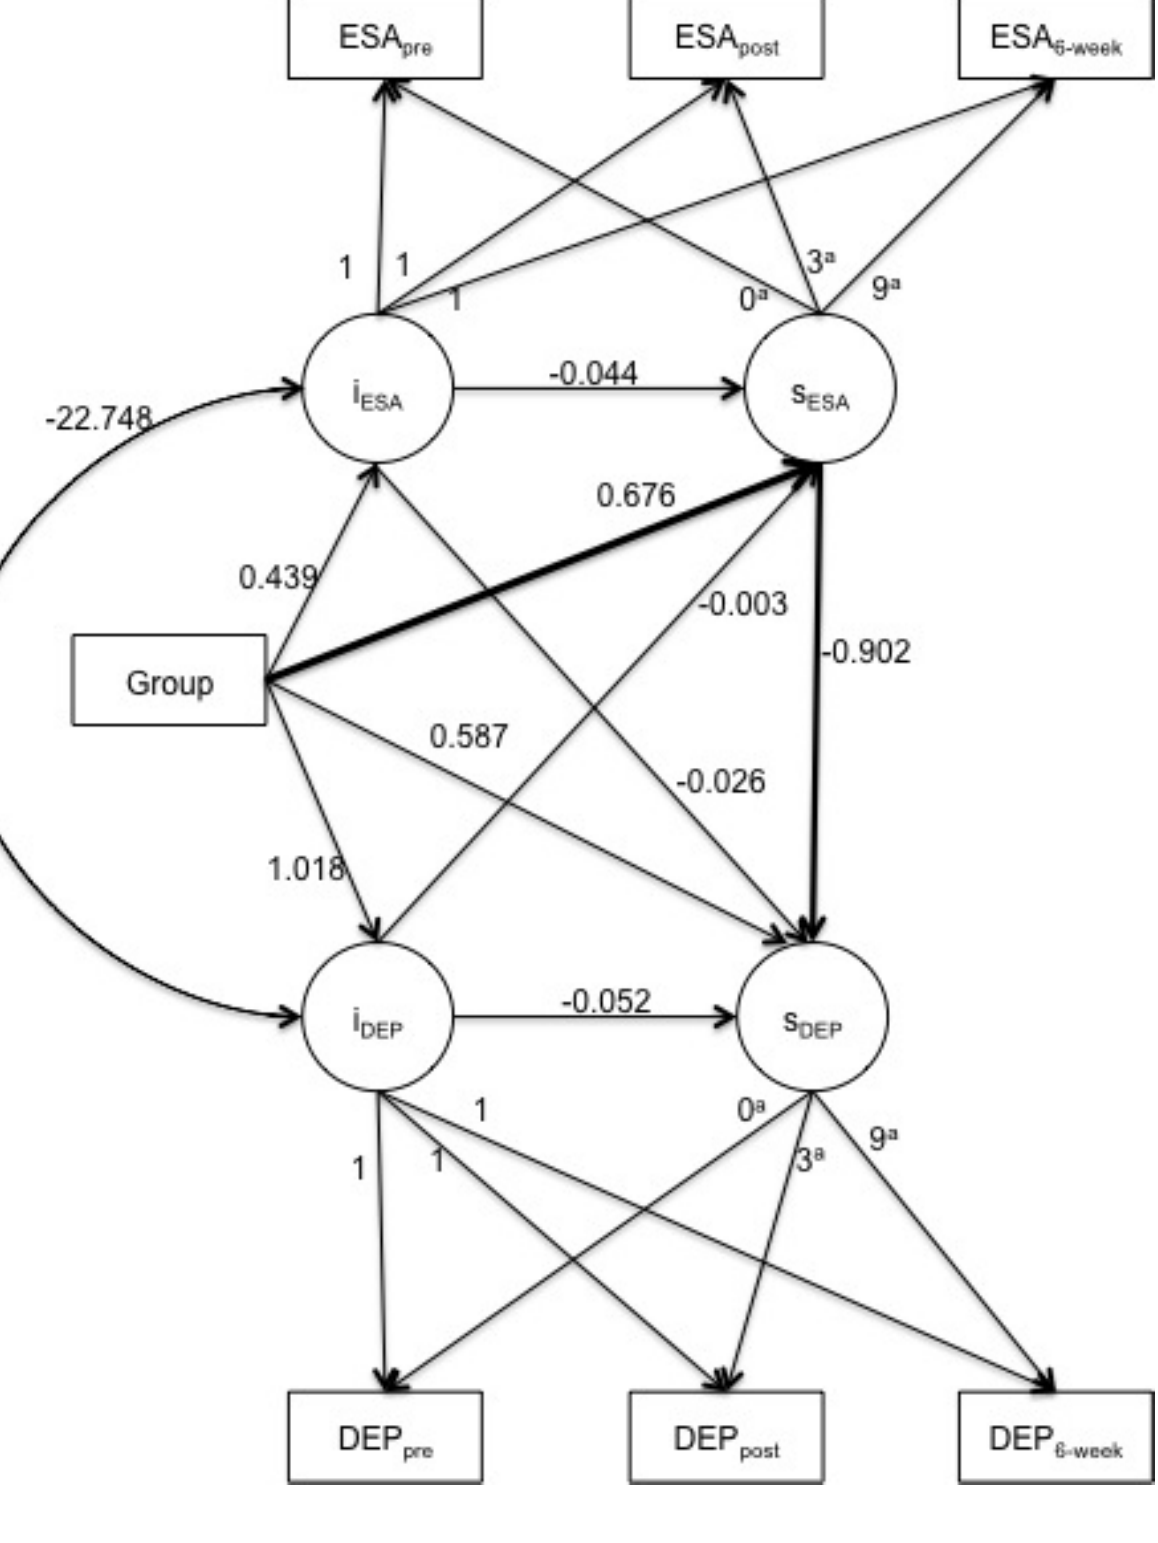
Figure 2. Parallel process latent growth curve model of the group effect on the growth of depressive symptoms via the growth of emotional self-awareness (ESA). Unstandardized estimates reported; boldface lines represent statistically significant pathways. a Time interval from pretest by week. DEP pre, post, 6-week , ESA pre, post,6-week = the observed score of the Depression Anxiety Stress Scale depression subscale and ESA scale at pretest, posttest, and 6-week follow-up, respectively; Group = intervention program condition; iDEP = latent intercept of depression; iESA = latent intercept of ESA; sDEP = latent slope of depression; sESA = latent slope of